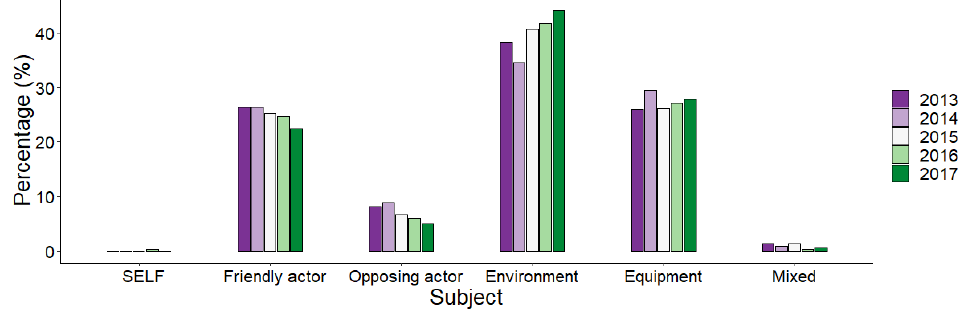
Figure 39. Deployment distribution between subject of the goal network and year.